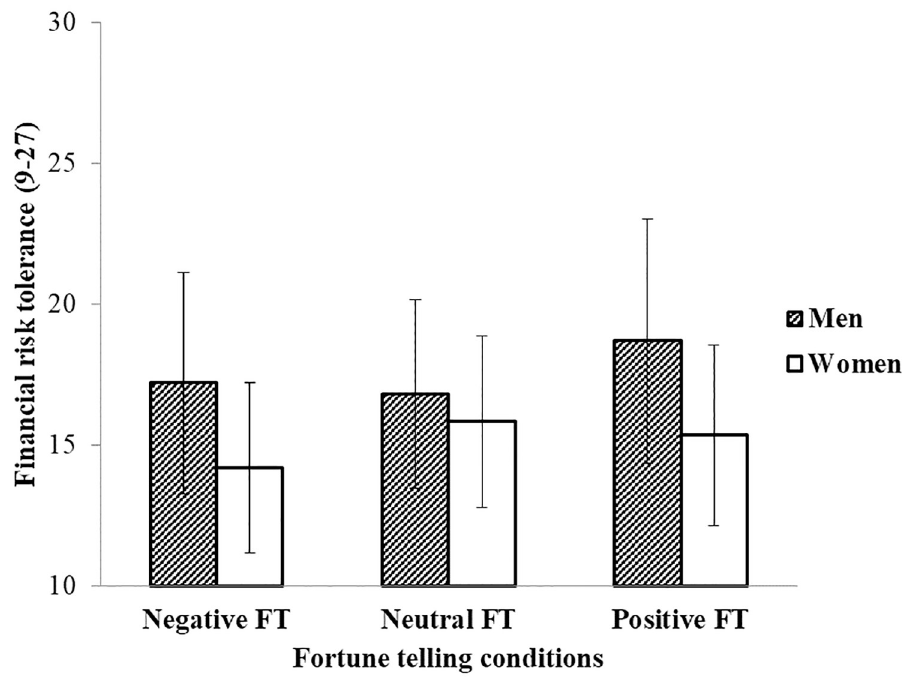
Fig 1. Mean financial risk tolerance among fortune telling conditions for men and women. Error bars represent standard deviations in Study 1.